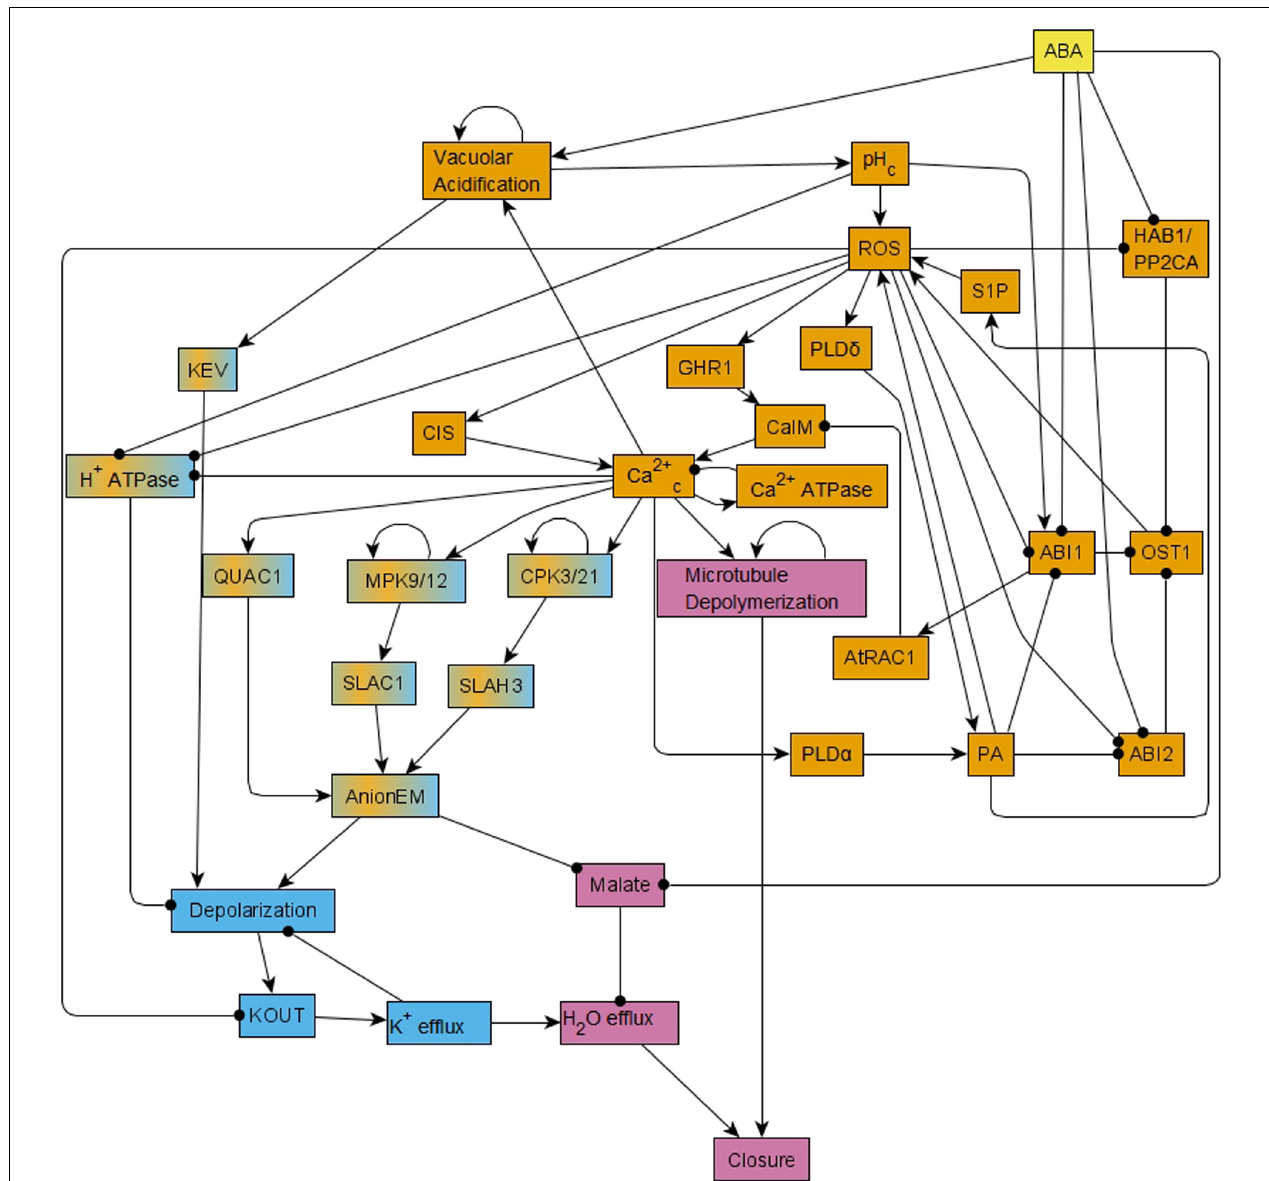
FIGURE 1 | Simplified version of the network that forms the basis of the Boolean model of ABA induced stomatal closure. This network is reduced from the 49-node network in Maheshwari et al. (2019) using methods of causal logic reduction (Maheshwari and Albert, 2017) and binary transitive reduction (Albert et al., 2007); it preserves all the relationships among nodes of the 49-node network via edges or paths. Each edge that terminates in an arrow indicates an activating relationship and each edge that terminates in a black circle indicates an inhibitory relationship. This reduced network is presented here just for ease in visualization; all the analysis in this work was conducted on the 49-node network presented in Figure 1 of Maheshwari et al. (2019). This network contains positive feedback loops, i.e., cycles of directed edges that contain no or an even number of inhibitory edges, for example ROS – • ABI1 – • OST1 → ROS. It also contains negative feedback loops, i.e., cycles of directed edges that contain an odd number of inhibitory edges, for example Depolarization → KOUT → K + efflux – • Depolarization. This network has two strongly connected components (SCCs) i.e., subnetworks in which every pair of nodes is connected by at least two paths of opposite direction. These two SCCs are represented in orange and light blue colors. Nodes of the orange SCC can reach the nodes of the light blue SCC via paths; the nodes linking these two SCCs are shown in a mix of orange and light blue colors. The signal ABA reaches all the nodes of the network. The out-component of this network leads from the two SCCs to the Closure node and is represented in pink